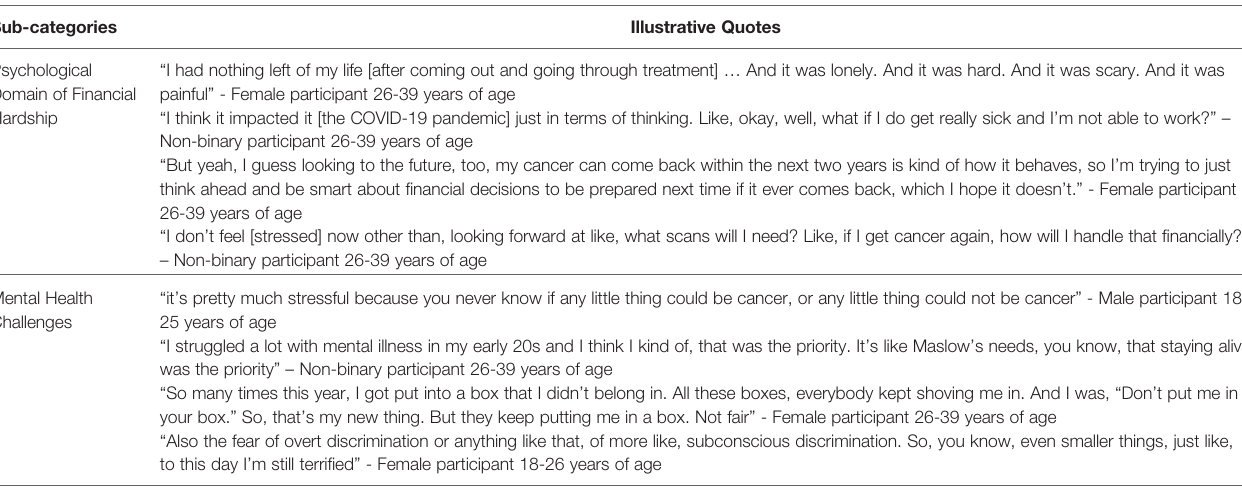
TABLE 3 | Psychological Financial Hardship and Mental Health Challenges – Sub-categories and Illustrative